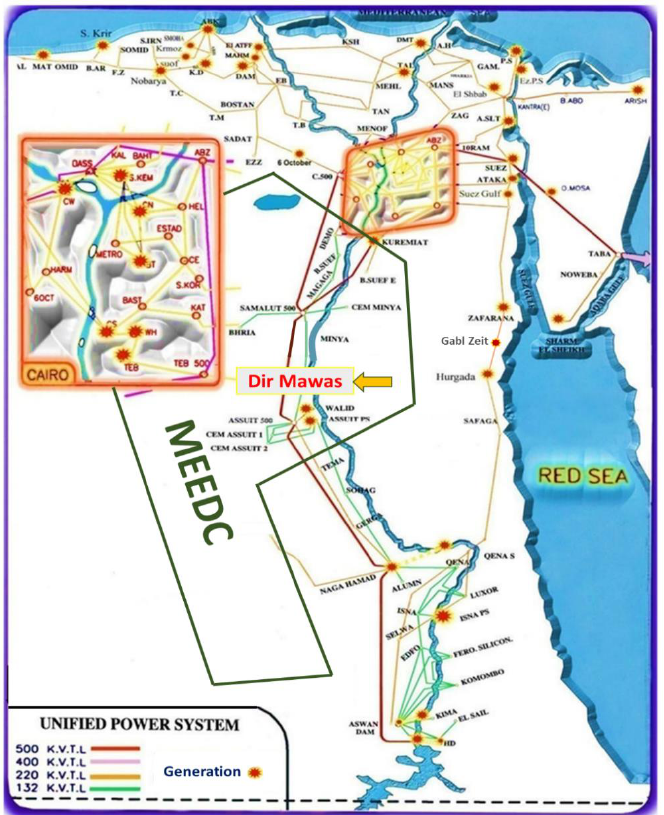
Figure 1. Location of the case study on the Egyptian electricity map.